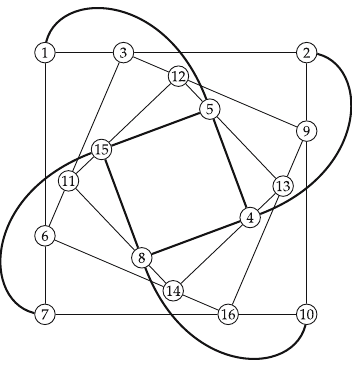
Figure 13: The unique 16 396 - con fi guration inducing a triangular matroid.